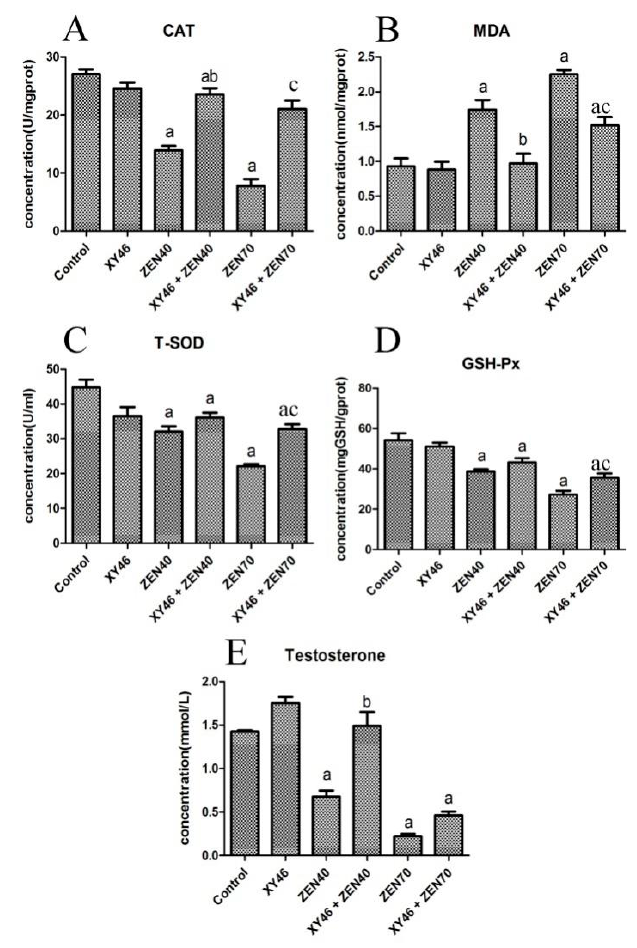
Figure 7. The detected concentrations of substances indicating oxidative damage to the mice testes and the concentration of testosterone in the mice serum, showing: ( A ) representative CAT levels in the testicular tissue, ( B ) MDA levels, ( C ) T-SOD levels, ( D ) GSH-Px levels, and ( E ) testosterone levels in the serum. Key: ′ a ′ —significantly different result compared to the control group ( p < 0.05), ′ b ′ —xy46 + ZEA40 result that is significantly different from the ZEA40 result ( p < 0.05), and ′ c ′ —xy46 + ZEA70 result that is significantly different from the other groups ( p < 0.05). Seven mice were randomly selected from each group for testing.